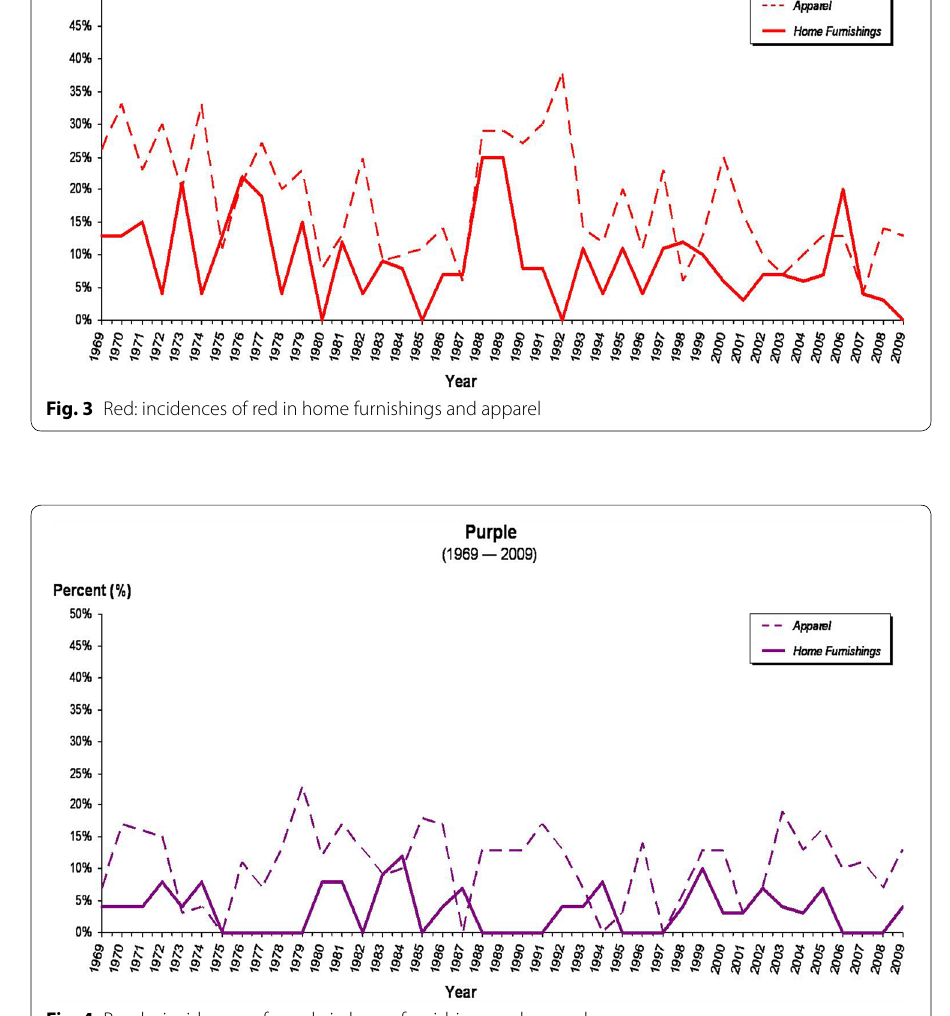
25 years) were the next longest cycles; in AP, red (38 years), purple (12 years), and black (at least 19 years) were the next longest. Lower incidence colors had the shortest cycle lengths. Gray (HF) and orange (AP) cycles did not exceed 5 years and often were just 2 years. In both HF and AP, cycle lengths varied within each color; blue and green each had a mix of short, medium, and long cycles. The ranges of cycle lengths in each cat- egory by color follow. (A + sign indicates that a cycle apparently began before 1969 or was not finished in 2009.) Yellow: HF (2–15 years), AP (2–6 + years). Orange: HF (2–6 years), AP (2–5 years). Red: HF (2–8 years), AP (until 2007 remained above 5% level and up to 35–40%).